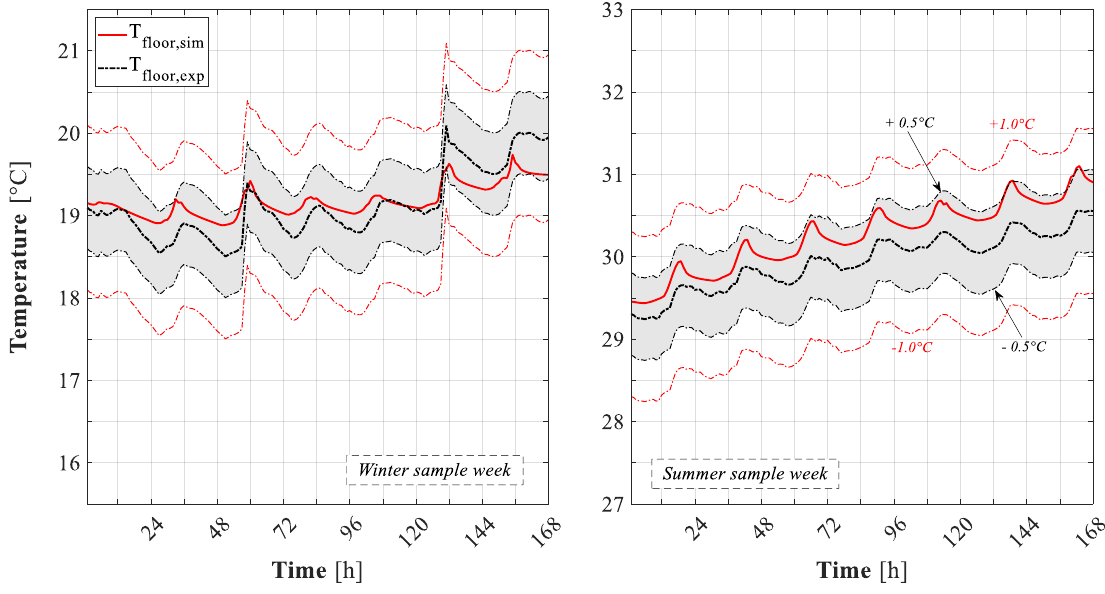
Figure 18. Floor temperature: simulated vs. experimental results (two sample weeks).